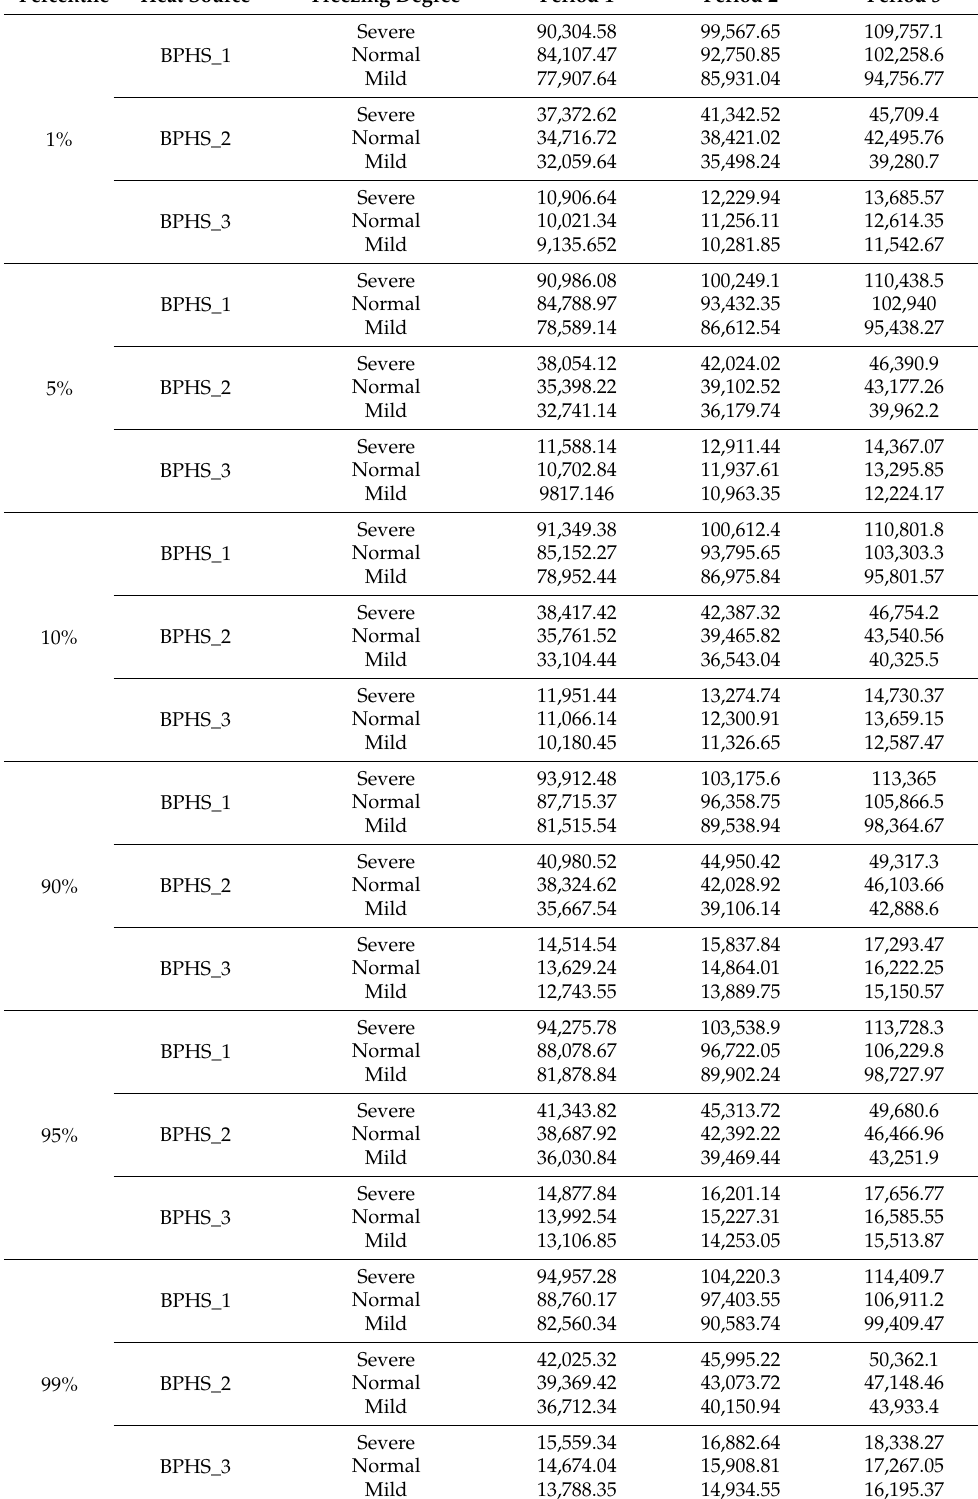
Table A3. Heat provisions undertaken by different peak-shaving heating sources under α = 0.6,